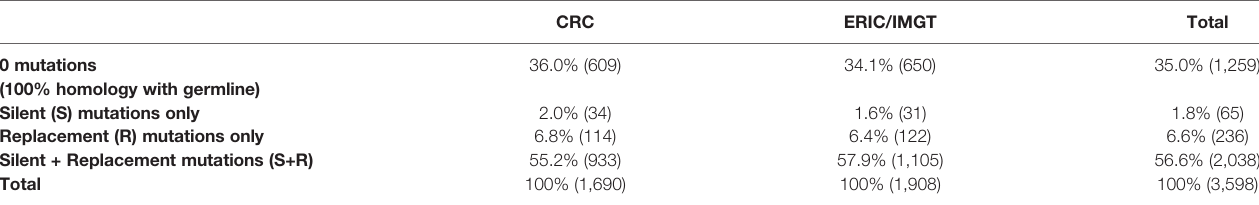
TABLE 1 | Distributions of mutation types between the CLL Research Consortium (CRC) and the European Research Initiative on CLL/ImMunoGeneTics (ERIC/IMGT). CRC ERIC/IMGT Total 0 mutations (100% homology with